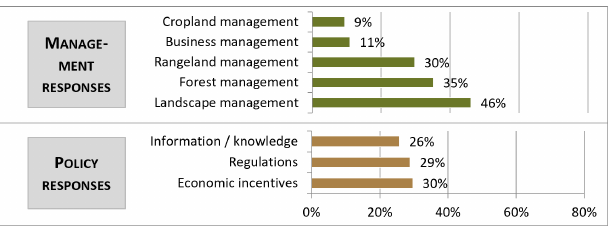
Fig. 8 . Land management (a) and policy (b) responses suggested to support the reference state of dehesas identified in the